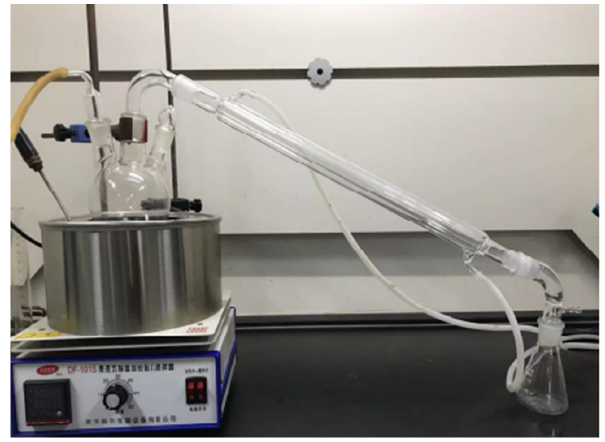
Figure 2. The experimental device of the chlorination reaction.